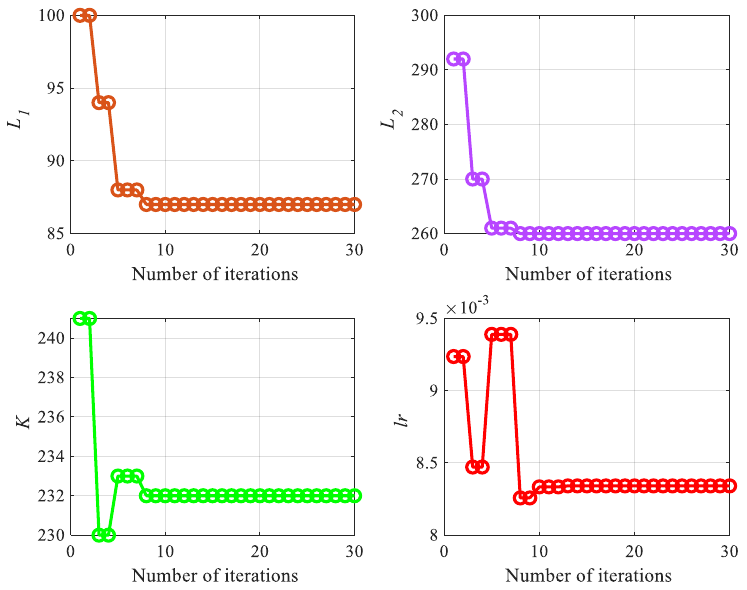
Figure 11. Variation of model hyperparameters. Table 6. The result of ISSA search for hyperparameters.